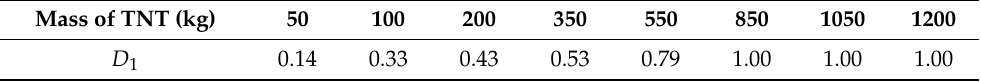
Table 2. Degree of damage to surface flood discharge holes subjected to underwater contact